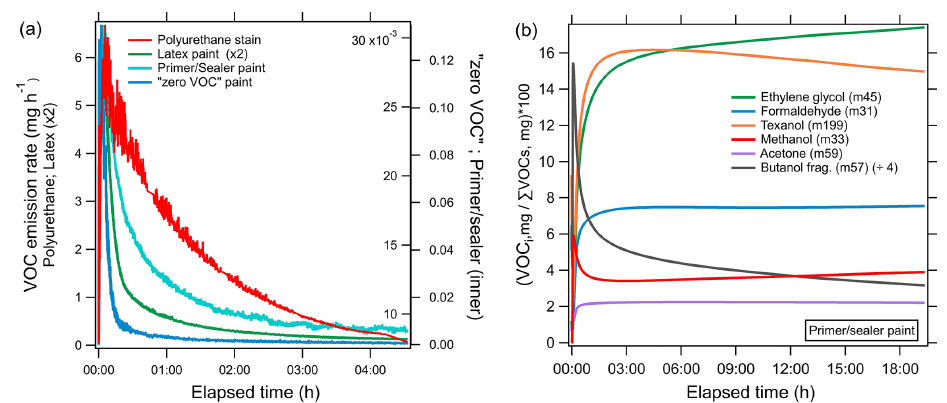
Figure 7. (a) Emission rates (milligrams per hour) of all measured VOCs summed during evaporation experiments of different coating types, i.e., polyurethane stain (red), latex paint (green), primer and/or sealer paint (cyan), and zero VOC paint (blue). (b) Time series showing the percent of integrated mass emitted as an individual VOC (VOC i ) to the total measured integrated VOC mass for the evaporation of the primer and/or sealer paint. The most likely identity and detected mass of individual VOCs are indicated in the